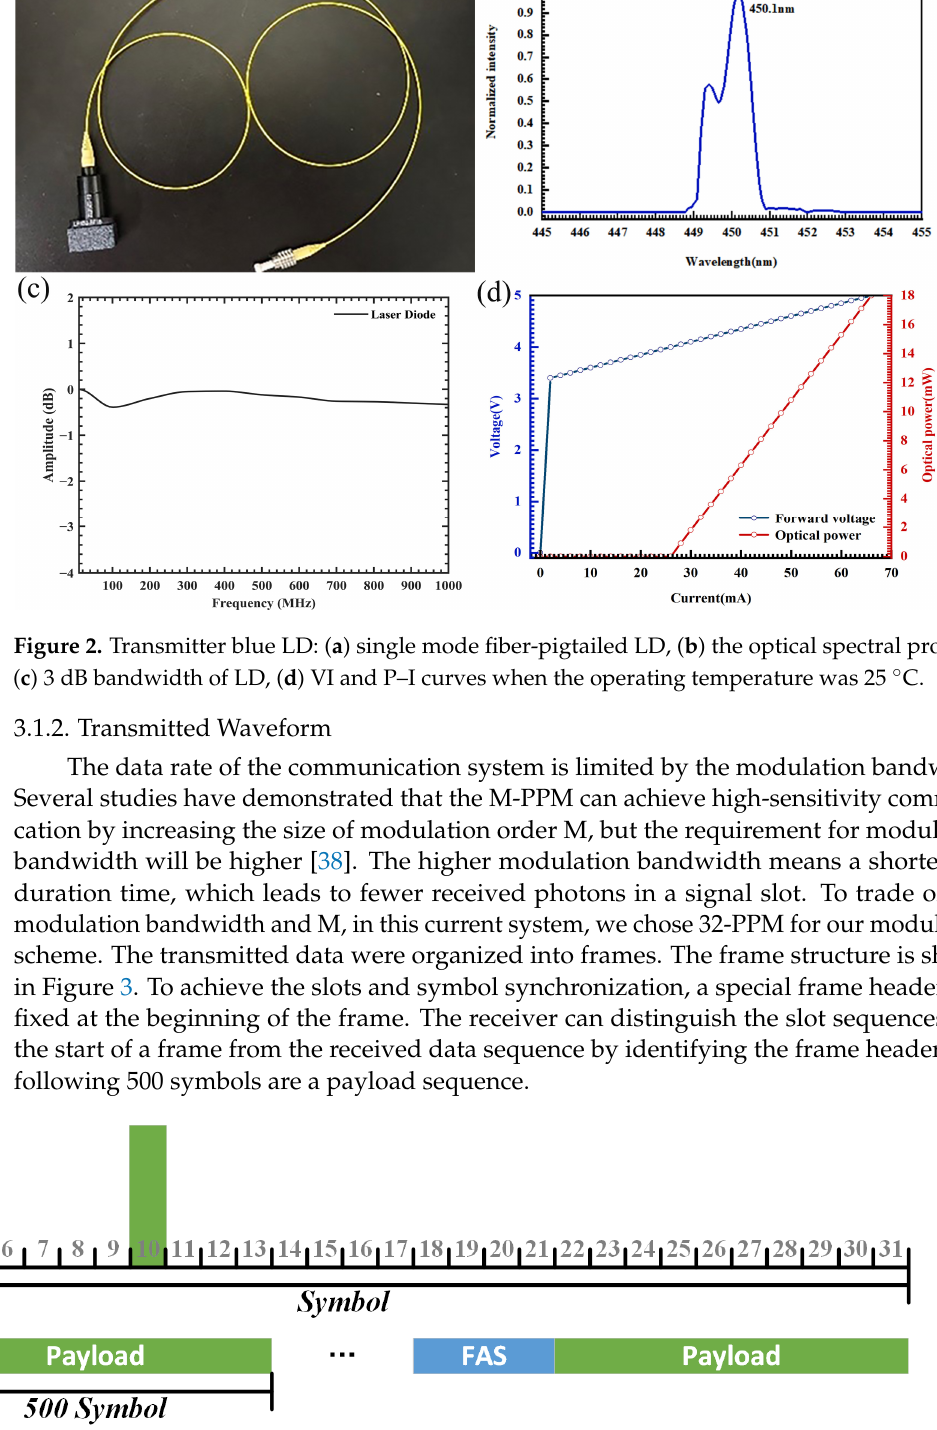
Figure 3. The signal frame structure.